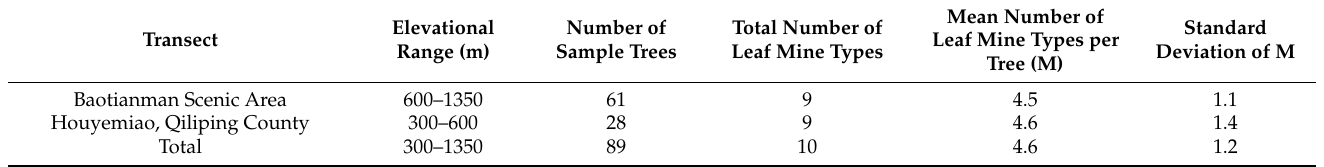
Table 1. Detailed information of the two transects for leaf mine sampling on Quercus variabilis at